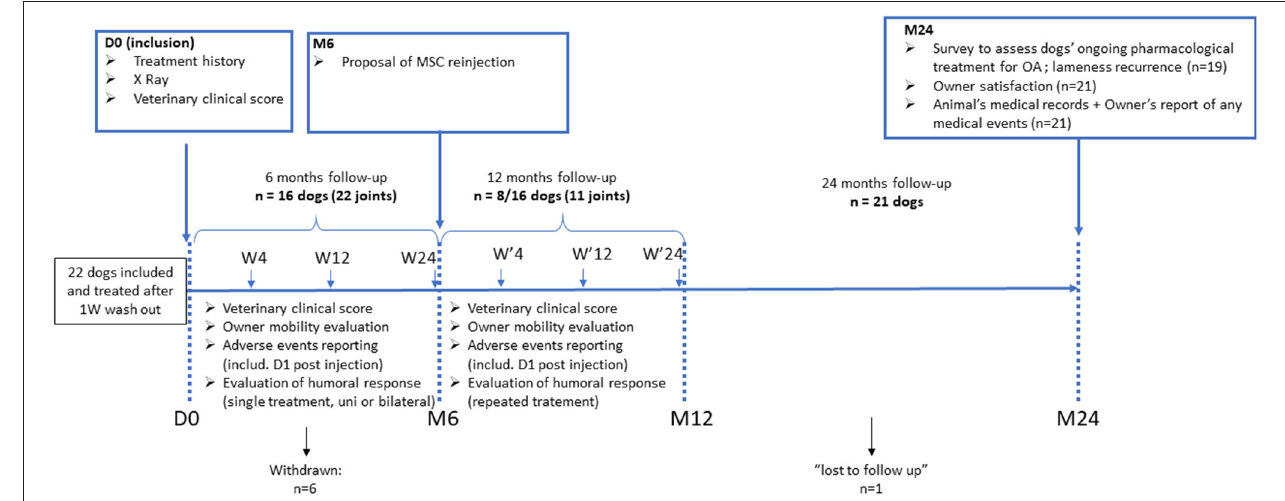
FIGURE 1 | Schematic overview of the study design.